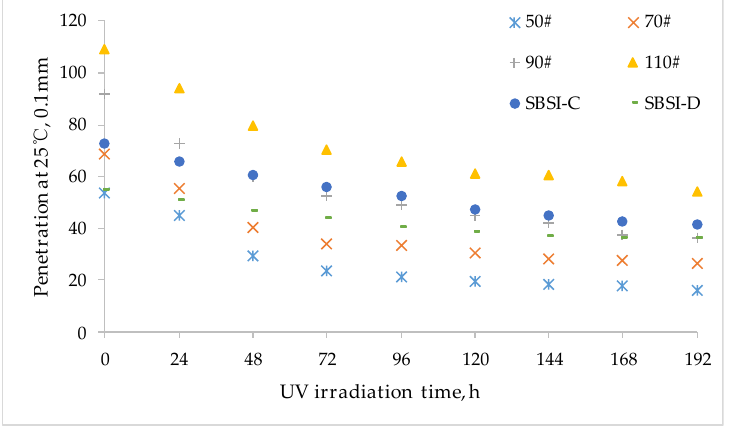
Figure 4. The penetration of asphalt with different UV irradiation time.